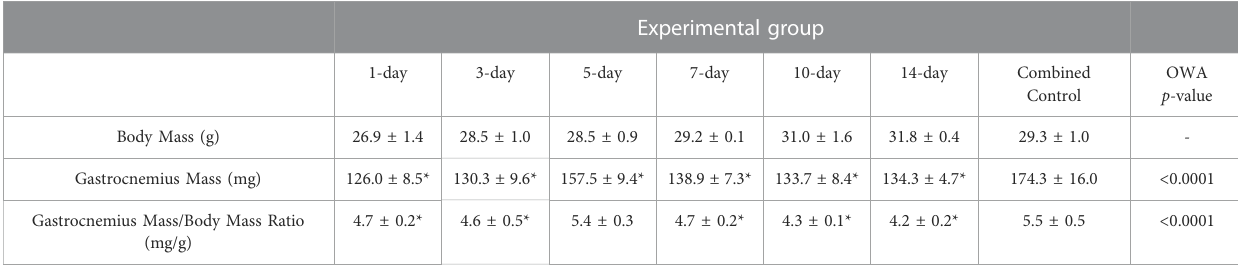
TABLE 1 Mouse body mass and gastrocnemius muscle mass.